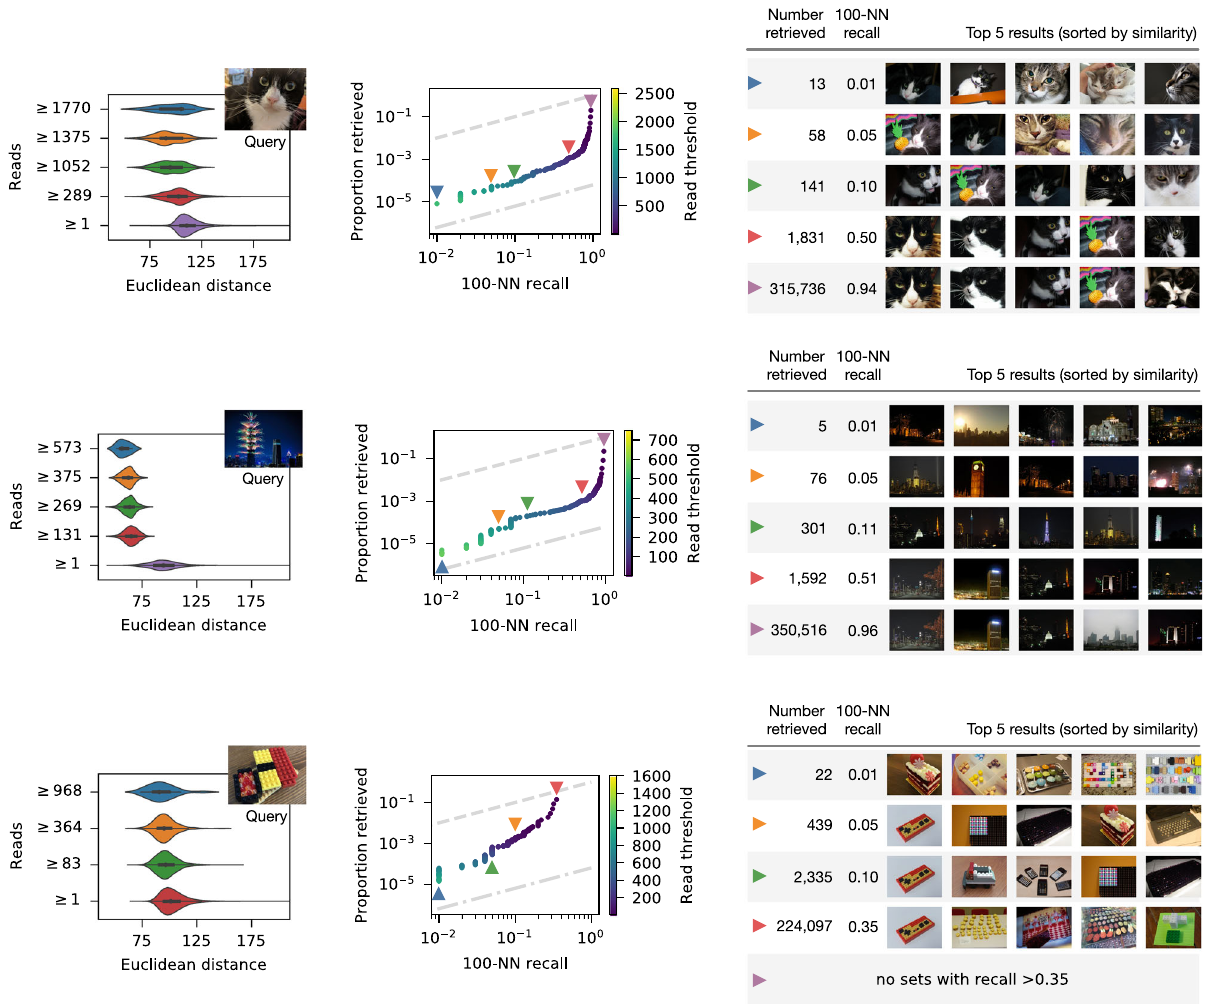
Fig. 3 Experimental results for three different query images. Janelle, the cat (top), a building with fi reworks (center), and Lego pieces assembled in the shape of sushi (bottom). A Distribution of Euclidean distances to the query image, among sets of images with sequencing read depth above a certain threshold. n = 1.6 million independent images. B The proportion of the entire dataset that must be retrieved ( y -axis) to retrieve a certain proportion of the 100 most similar images ( x -axis). Each point represents a threshold for which images with read depth above that threshold are considered “ retrieved ” . The dashed line indicates chance performance, while the dashed-and-dotted line indicates perfect performance. Colored triangles indicate the thresholds depicted in the other sub fi gures. C The top fi ve closest images to the query from result sets where images above a certain read depth threshold are considered “ retrieved ”